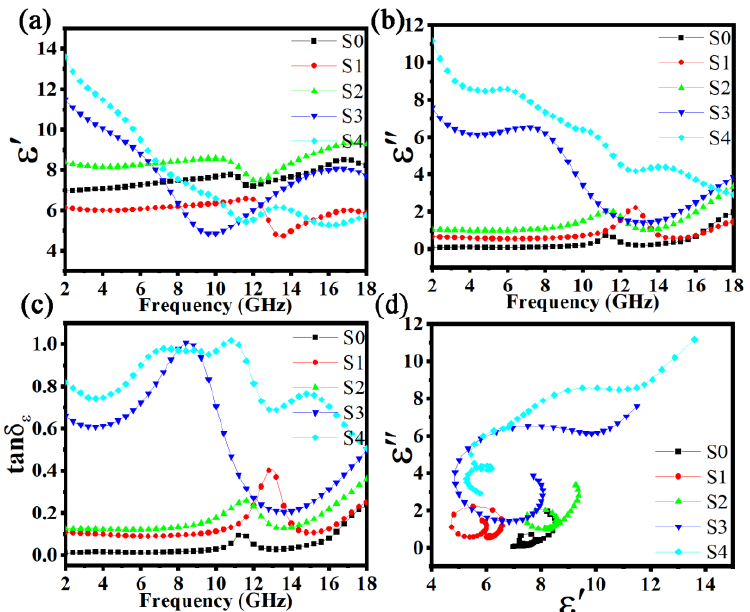
Figure 8. Dielectric parameters of the FeSiAl and FeSiAl@HC samples: ( a ) ε ′− f , (b) ε ” − f , ( c ) tanδ ε − f , and ( d ) Cole − Cole semicircles.